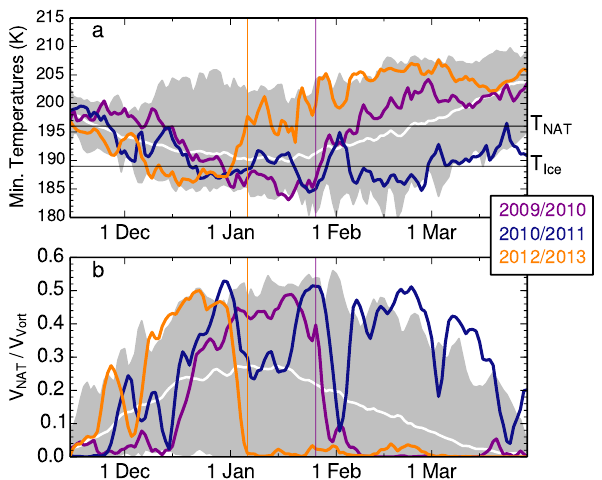
Figure 2. Time series of (a) minimum temperatures poleward of 40 ◦ N at 490K and (b) V NAT /V Vort (see text) from MERRA re- analysis. Individual lines show 2009/10 (purple), 2010/11 (blue), and 2012/13 (orange). Envelope shows the remaining years from 1979/80 through 2013/14. Thin vertical lines indicate the dates when the major SSW criteria were met in 2010 (purple) and 2013 (orange). Thin black horizontal lines in (a) indicate the NAT and ice PSC thresholds.